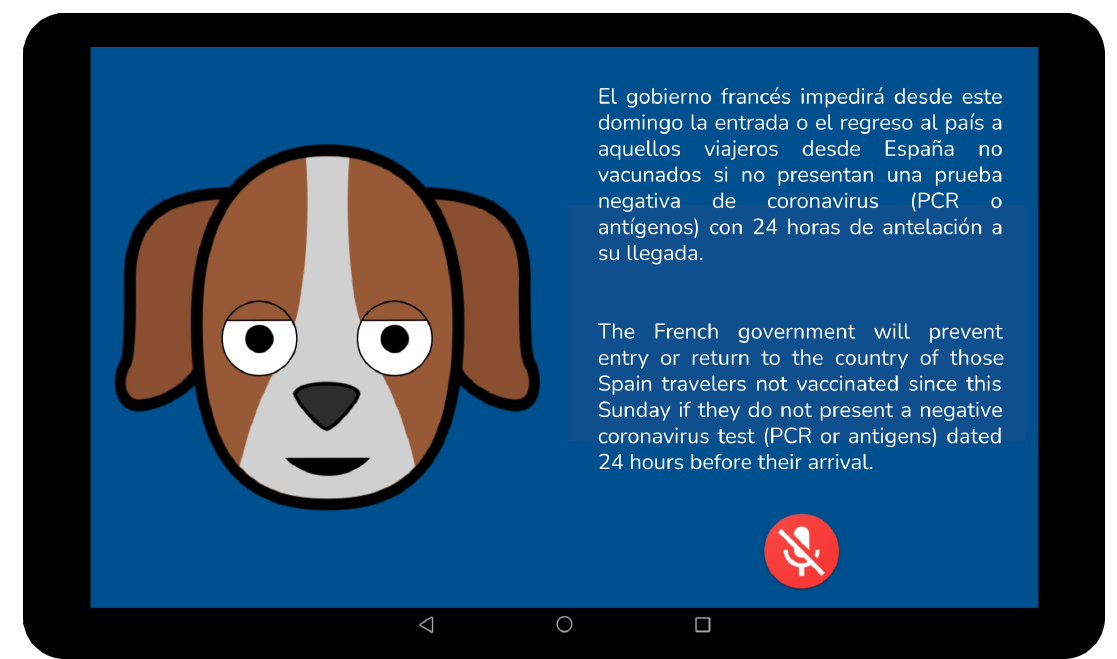
Figure 2. Lead paragraph